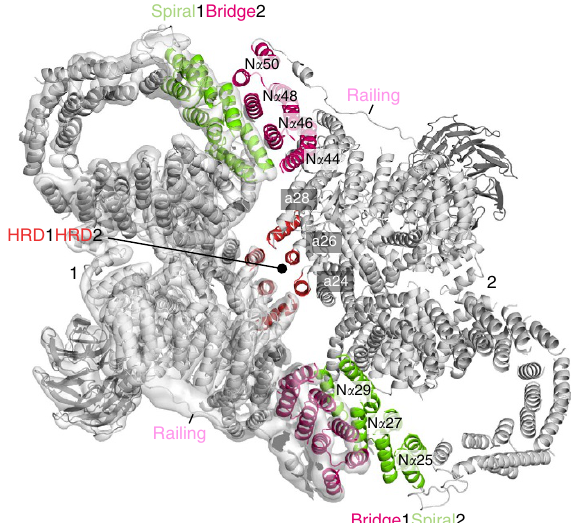
Figure 3 | The interface between the two KmTor–Lst8 heterodimers in the assembly. The KmTor dimer assembly is mediated by interaction between HEAT-repeats. The primary contacts form between the helices in the spiral (N a 25, N a 27 and N a 29) of one KmTor with helices in the bridge (N a 44, N a 46, N a 48 and N a 50) of the other. This interaction leads to a KmTor dimer that has two-fold rotational symmetry with the dyad axis between the two HRD domains ( a 24, a 26 and a 28) of the FATKINs where secondary contacts form. The cryo-EM density for one KmTor–Lst8 heterodimer is shown, contoured at 9 s everywhere except for the railing density, which is contoured at 4 s